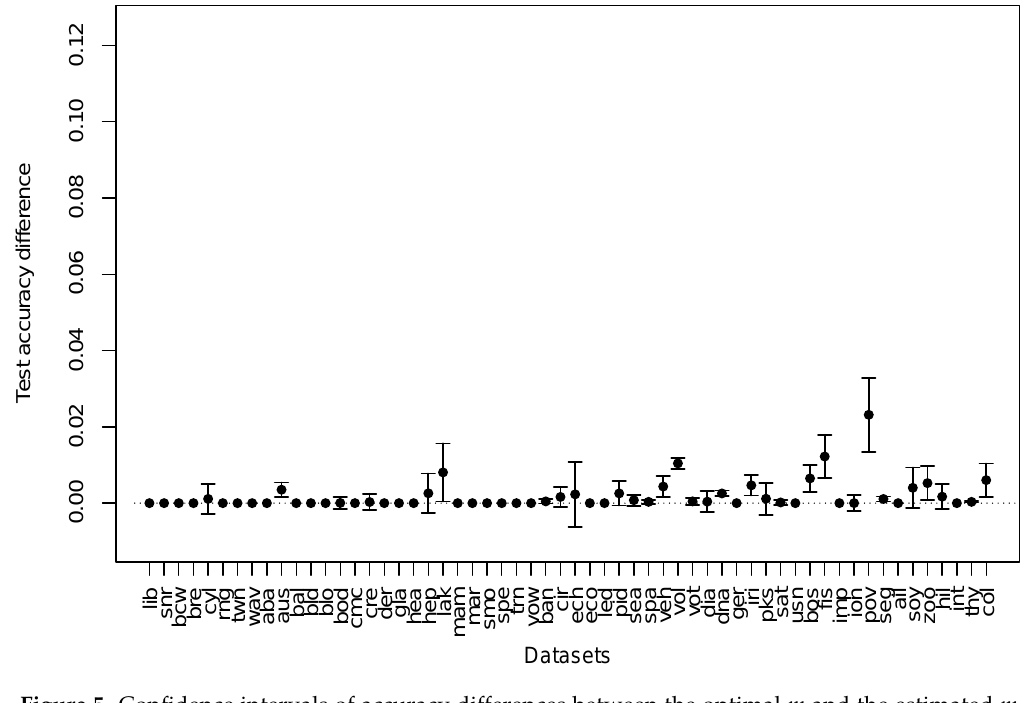
Figure 5. Confidence intervals of accuracy differences between the optimal m and the estimated m .